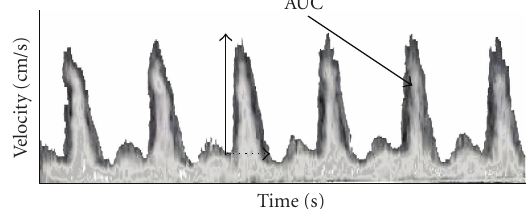
Figure 4: Esophageal Doppler tracings from descending aorta blood flow. Flow time and peak velocity are indicated by dashed and vertical arrows, respectively. Parameters derived from the latter measurements include corrected flow time (FTc), acceleration, and stroke distance. The area under the curve (AUC) is equivalent to stroke distance, the length traveled by an erythrocyte during a single cardiac cycle. Assuming that the flow is via a cylindrical path, the stroke volume (SV) is the product of aortic cross-sectional area and the stroke distance. Aortic blood flow is calculated from the product of heart rate and calculated SV and is not exactly equal to true cardiac output, as approximately 10% of total cardiac output is diverted to subclavian and cerebral arteries upstream to where flow is